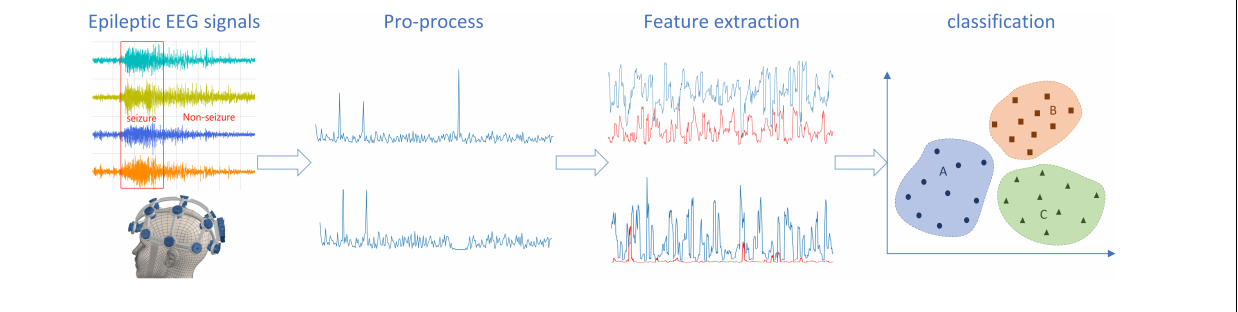
FIGURE 1 | The key steps of epilepsy detection.